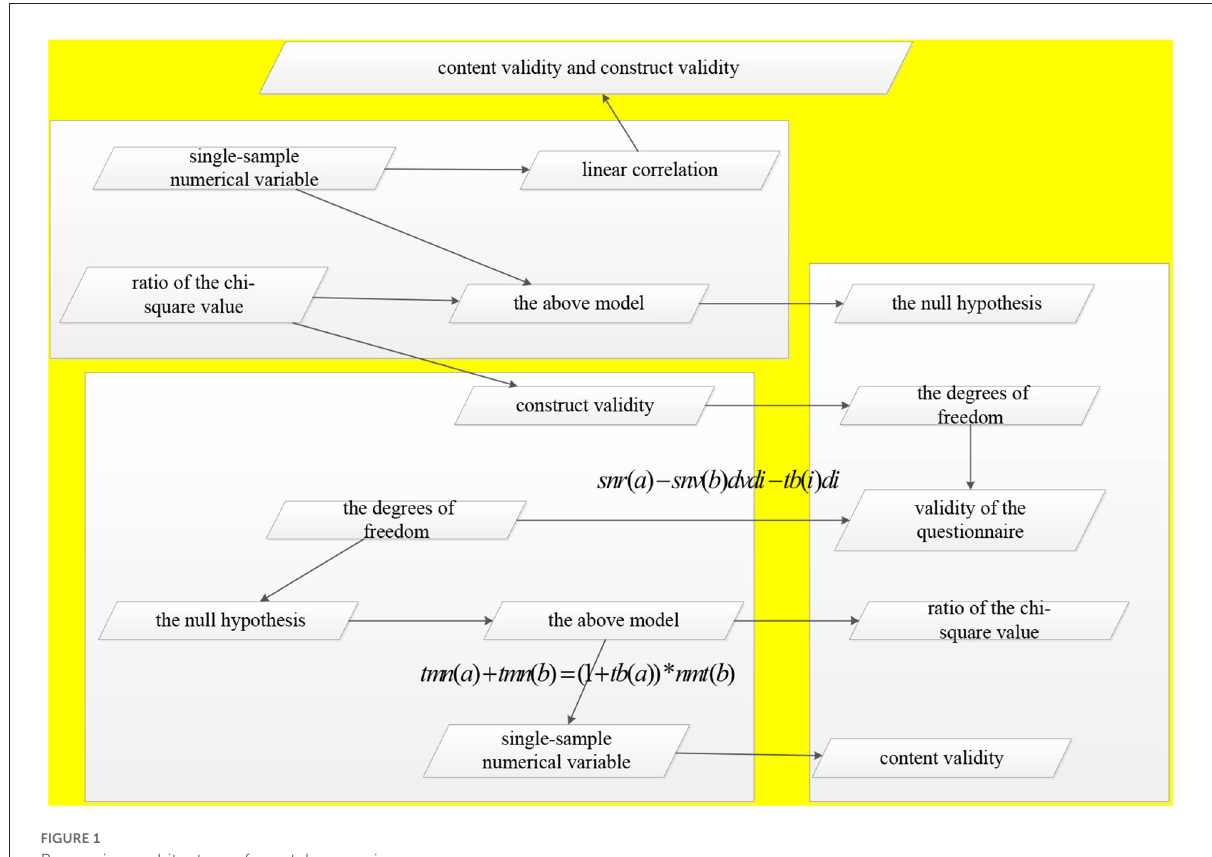
FIGURE1 Regression architecture of mental